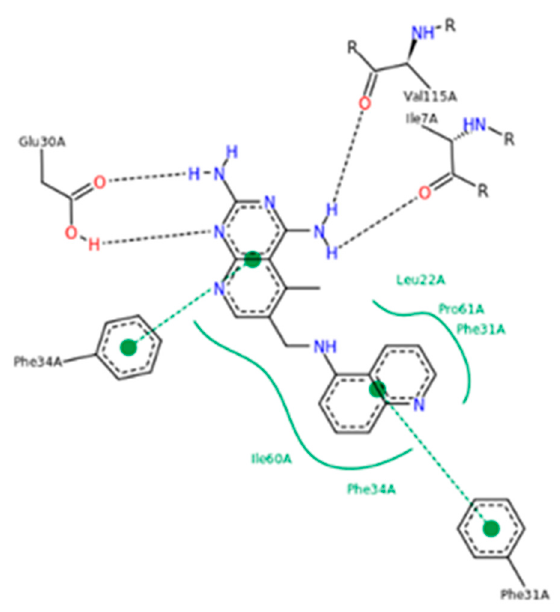
Figure 3. hDHFR–6-([5-quinolylamino]methyl)-2,4-diamino-5-methylpyrido[2,3-d]pyrimidine (SRI-9439) contacts (PDB ID 1KMS). Green lines show side-chain contacts, blue lines show main-chain contacts.